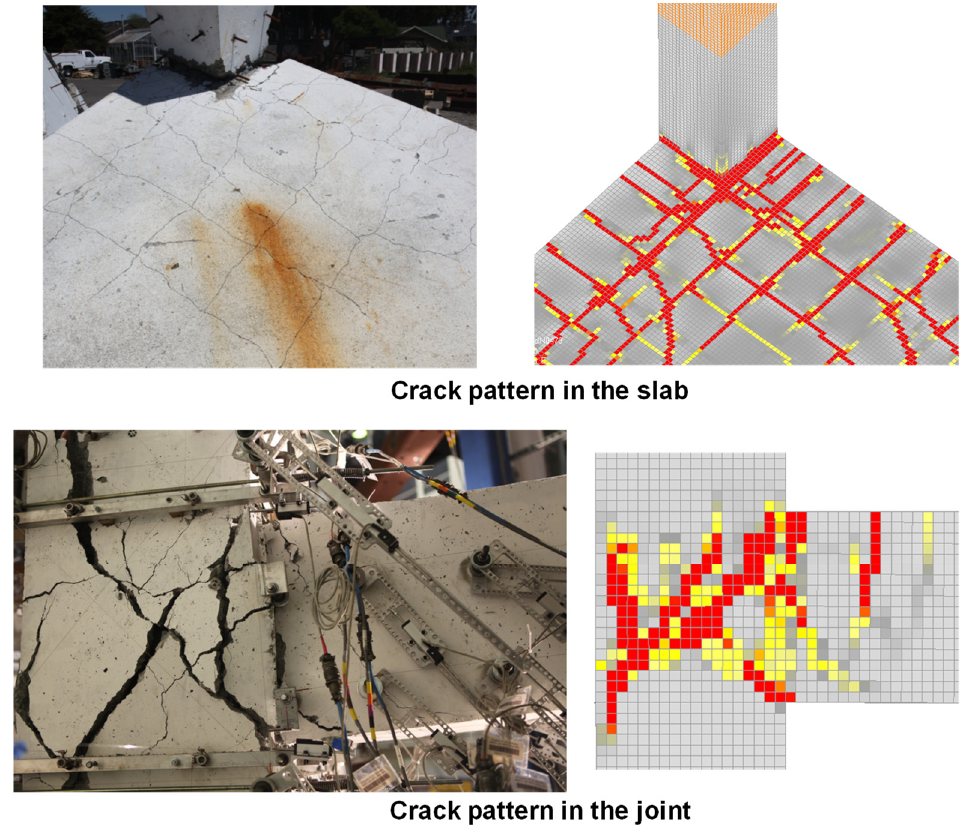
Figure 10. Comparison of crack patterns evaluated in FE analysis with the test observations.